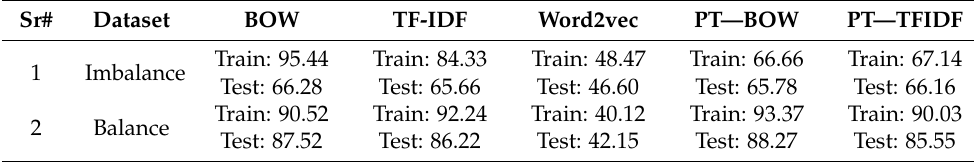
Table 6. Results of logistic regression.